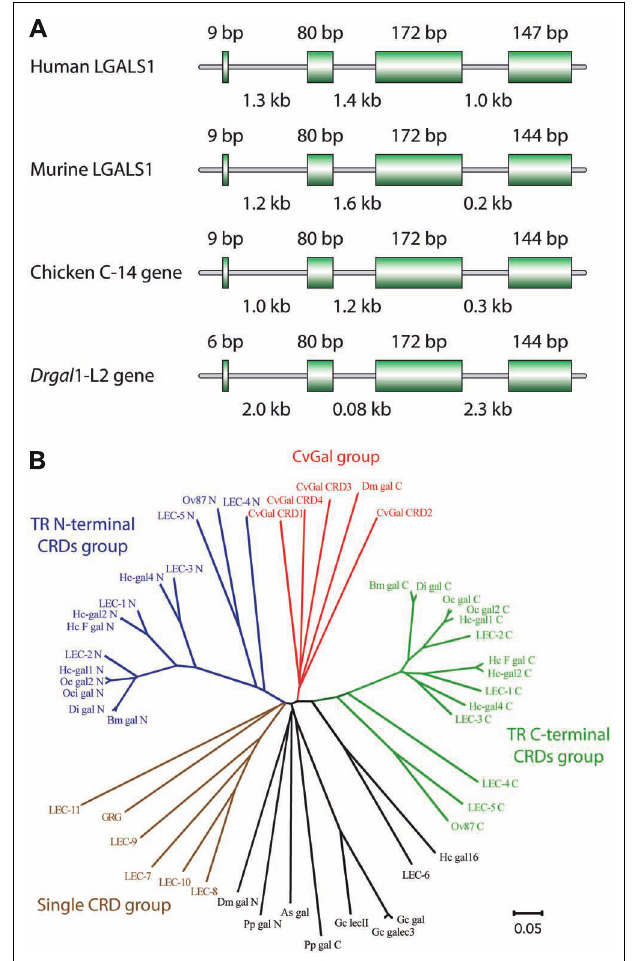
FIGURE 3 | Gene organization and phylogeny of galectins. (A) Genomic structures of galectin-1 or galectin-1 like protein from human, murine, chicken, and zebrafish ( Danio rerio ). Coding sequences (exons) are represented by boxes, with their sizes noted above each box. Intron sizes are shown below. (B) Phylogenetic analysis of invertebrate galectins modified based onTasumi andVasta (2007).The unrooted tree constructed by the N-J distance method is